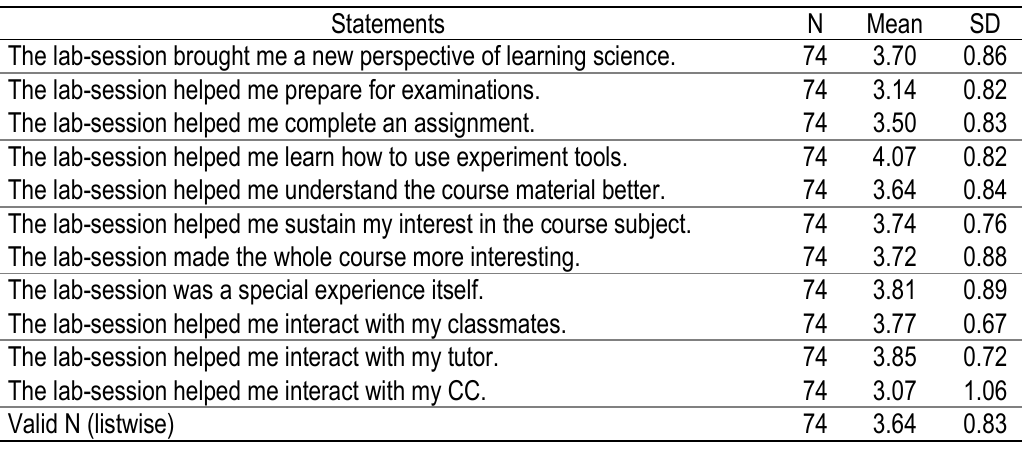
Table 5. Learning